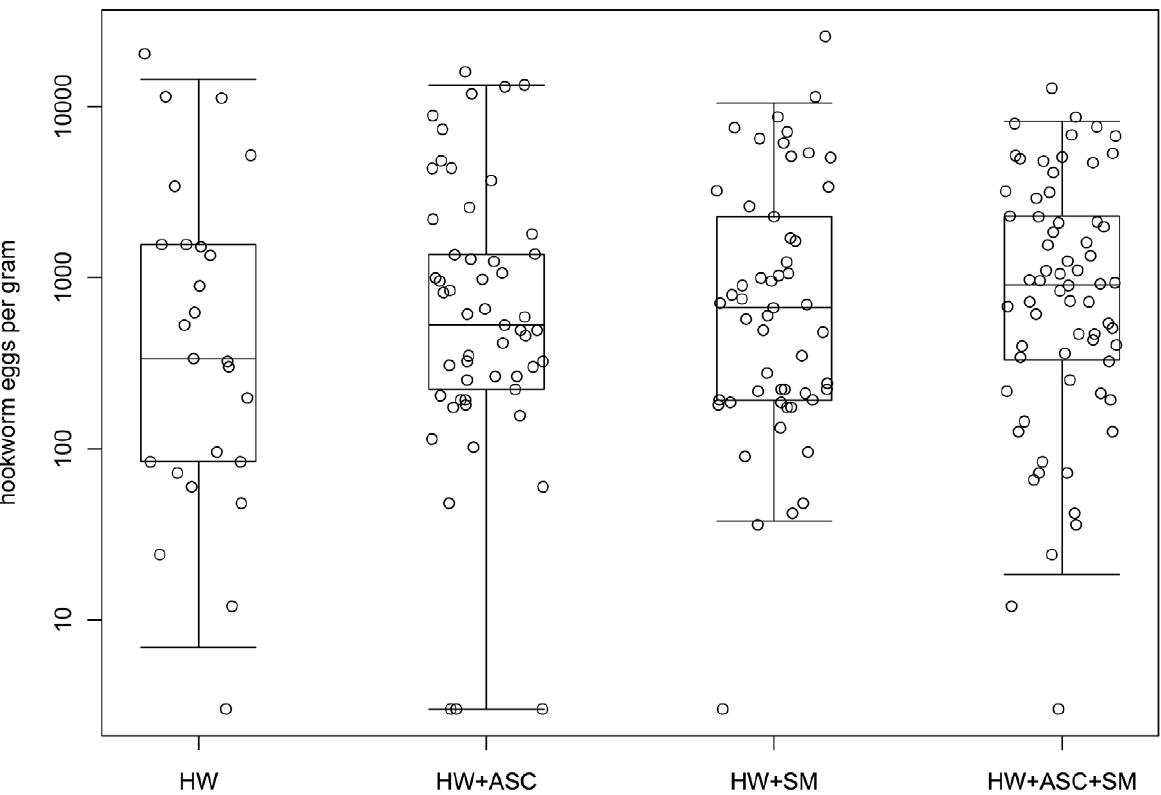
Figure 1. Fecal egg counts in hookworm mono- and co-infected individuals. Footnotes: Circles represent individual values for eggs per gram of feces (epg) and are shown on a logarithmic scale. Boxes indicate the median and the quartiles for each group and the whiskers indicate the 95% ranges. Groups are split in hookworm mono-infected (HW), co-infected with A. lumbricoides (HW + ASC), co-infected with S. mansoni (HW + SM), and triple-infected individuals (HW + ASC + SM). Kruskal-Wallis test on differences in hookworm egg counts between groups was not statistically significant ( p =0.523).